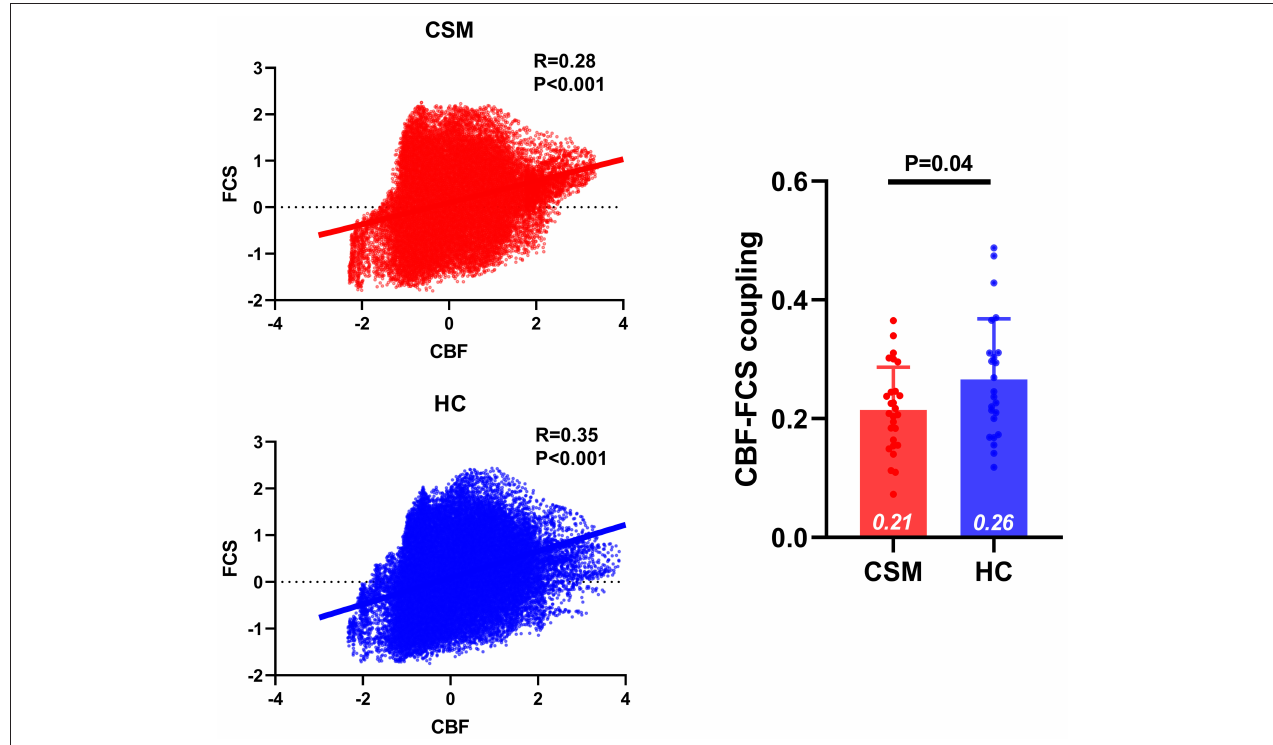
FIGURE 1 | The CBF–FCS coupling changes in the whole gray matter of cervical spondylotic myelopathy (CSM) patients. Scatter plots show the spatial across voxels correlations between CBF and FCS in CSM patients (red) and healthy controls (blue). Although there is significant correlation between CBF and FCS in both CSM patients and healthy individuals, compared to healthy individuals CSM patients display significantly weak CBF–FCS coupling. Error bars represent the SD. CBF, cerebral blood flow; FCS, functional connectivity